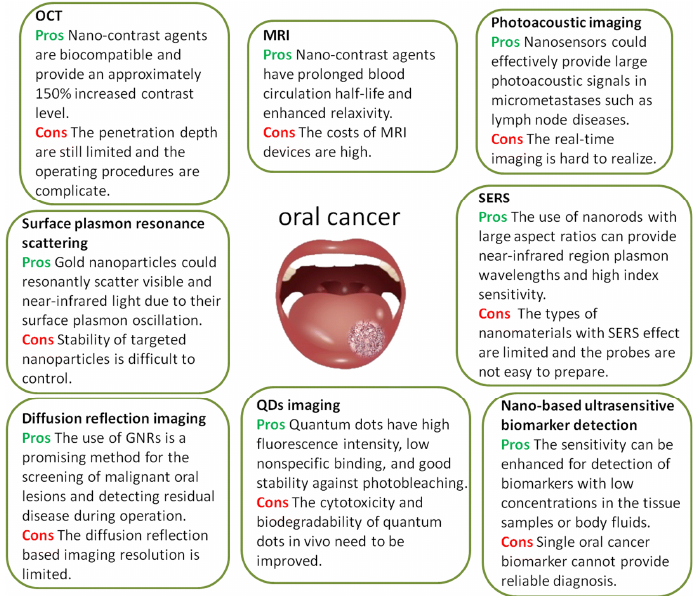
Figure 1. The pros and cons of different nanotechnology for bioimaging and biomarking [33]. Alternatively, different nanocarriers including liposomes, micelles, polymeric NPs, dendrimers, hydrogels, and others have portrayed tremendous opportunities in cancer therapies, including those for oral cavity carcinomas, due to their beneficial effects that have been proven in various research [36]. There are 51 types of nanomedicines that were approved by the Food and Drug Administration (FDA) in 2016, a figure which signifies the promising results of NPs in drug delivery systems [37]. For both local and systemic drug deliveries, the sublingual and buccal mucosal regions are more commonly chosen as these regions are highly vascularized, specifically for oral cancers [38]. Various dosage forms such as sprays, tablets, films, and patches incorporate NPs for therapeutic benefits [38]. Among all of the types of nanocarriers, the hydrogel is an excellent carrier that is broadly used in pharmaceutical applications and is widely studied for its positive effects on mucosal drug delivery [39]. Drug resistance is one of the main issues in the drug delivery of chemotherapeutic agents; however, this can be overcome by using this nanotechnology-based drug delivery system through encapsulation, attachment, and the conjugation of drugs or therapeutic biological products to nanocarriers [40,41]. 5. Mechanism of Cytosolic Delivery of Drugs The cellular internalization of nanocarriers is governed by their surface characteris- tics, size, and shape. The internalization can occur through different pathways; however, endocytosis signifies an attractive strategy for cellular internalization. The entrapment of a nanocarrier after its internalization in the endosomal compartment also represents an additional barrier for targeted drug delivery to the specific cell site. Moreover, transloca- tion to the cytoplasm is prevented by the membrane of the lysosome and endosome. The therapeutic drug may undergo enzymatic degradation in the lysosomes. Therefore, dif- ferent approaches are explored to enhance cytosolic delivery. In one approach, specific microenvironments such as pH, redox, and enzymes in the compartment have been found to facilitate drug release. However, the second approach emphasizes disrupting the endo- somal membrane either via membrane-disrupting peptides or endosmotic polymers [42].